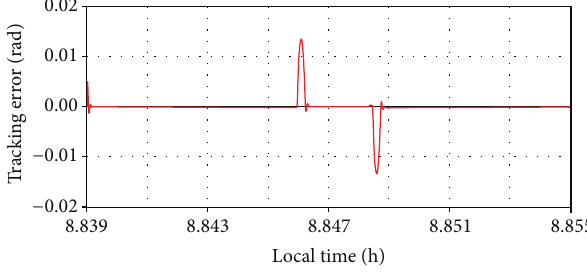
Figure 19: The tracking error for resistant